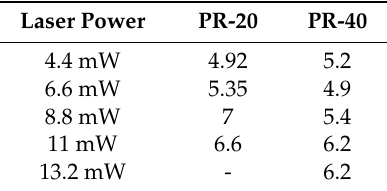
Table 4. Voxel aspect ratio for a writing speed of 90 µ